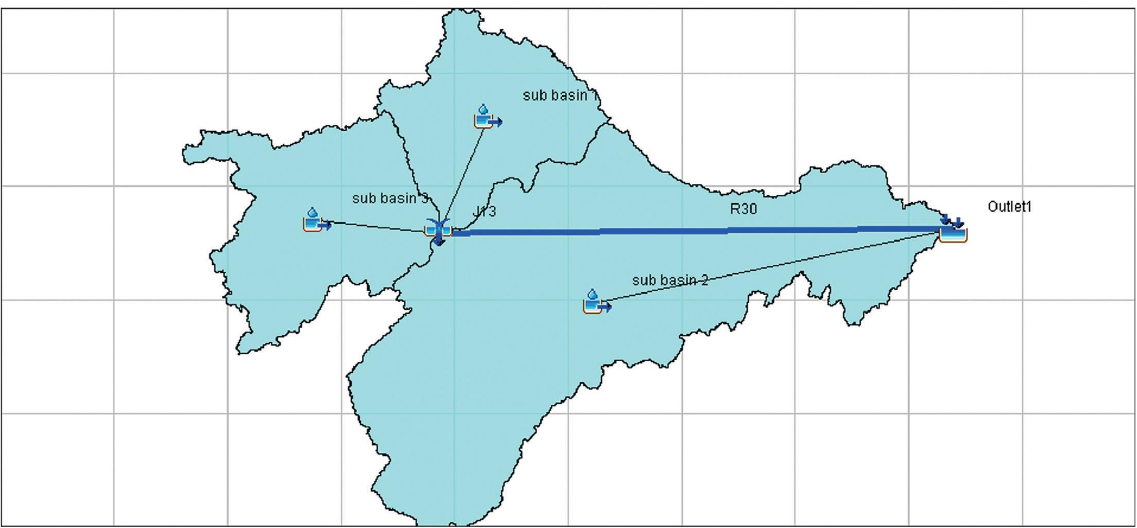
Figure 2: HEC-HMS model development.